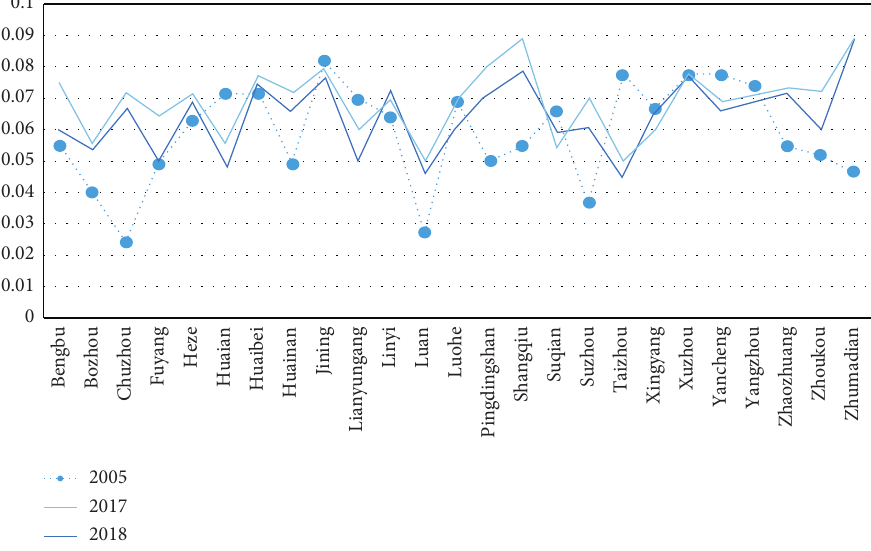
Figure 5: Comparison of green development competitiveness among cities.